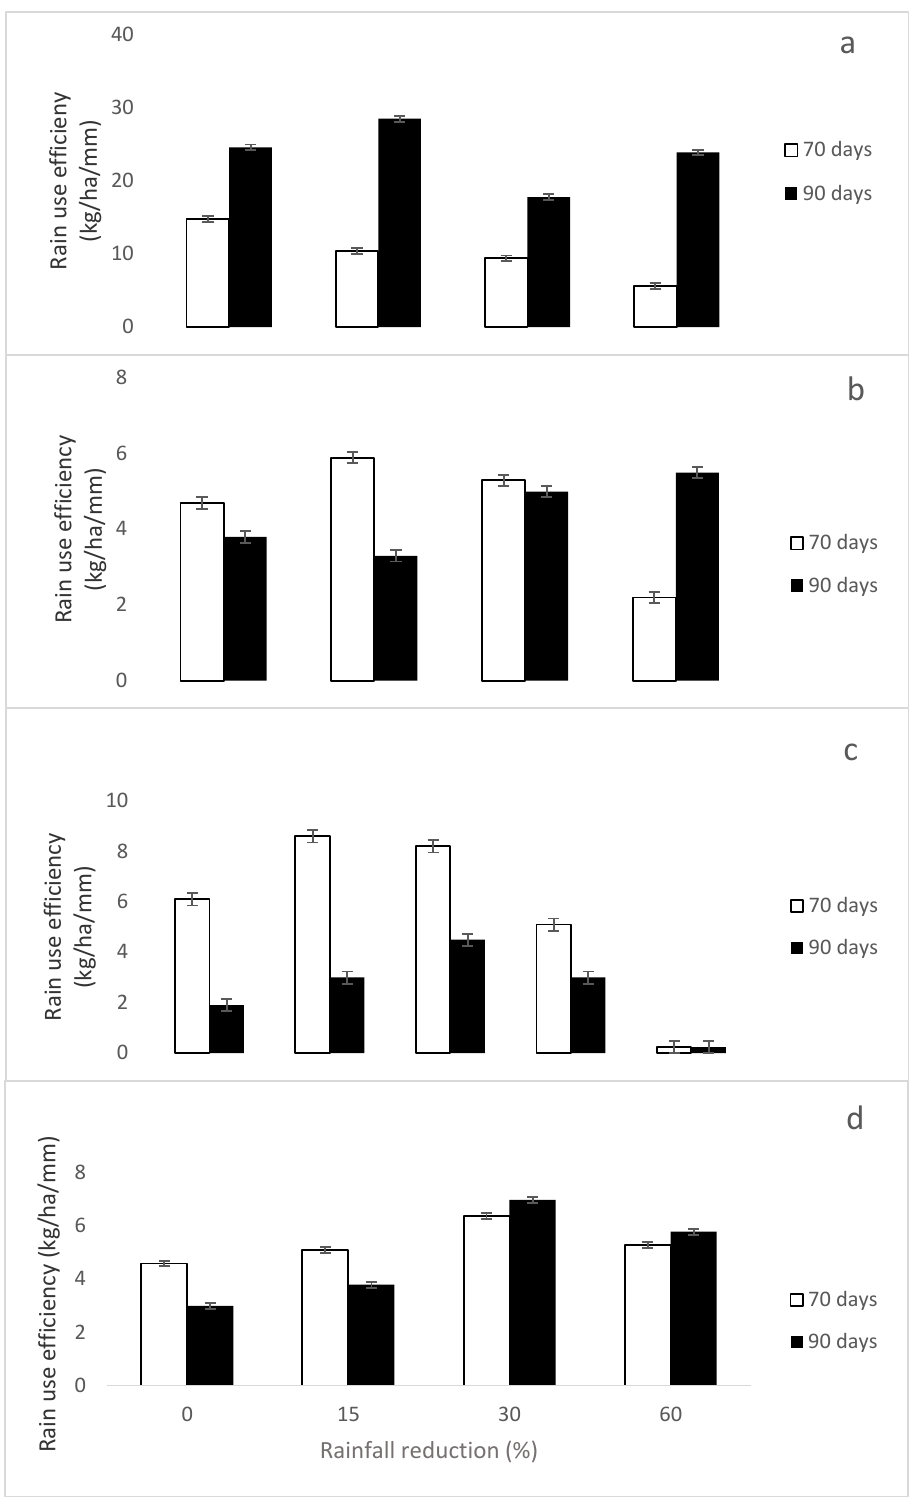
Figure 6. Interaction effects of rainfall reduction and resting period on rainwater use efficiency in ( a ) spring 2016/17, ( b ) spring 2017/18, ( c ) autumn 2016/17 and ( d ) autumn 2017/18 (bars indicate standard error values).